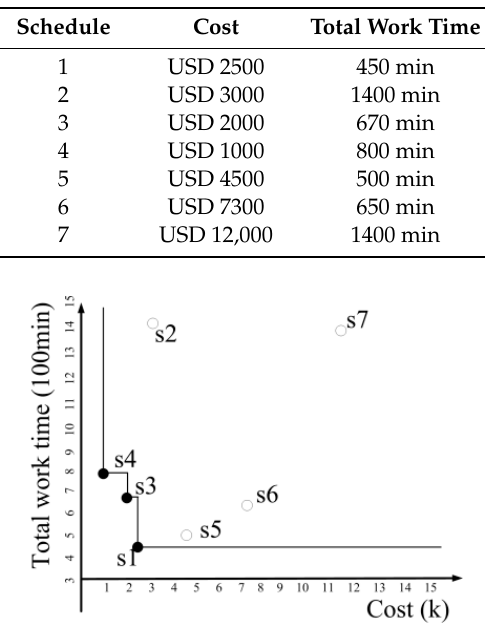
Figure 1. The example of skyline schedules.